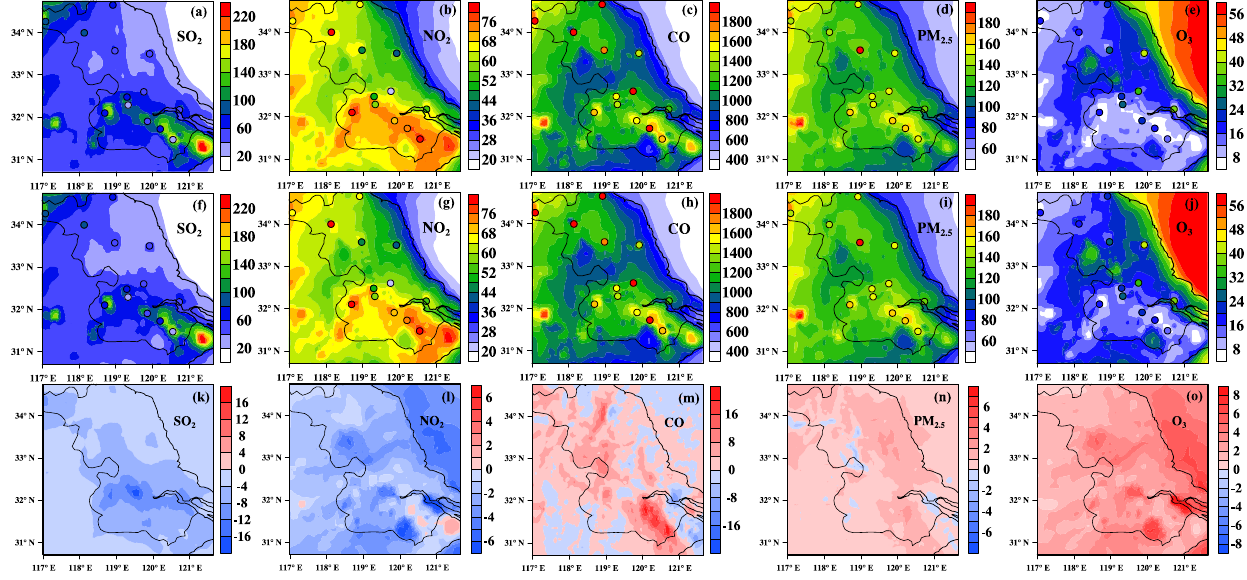
Figure 3. The spatial distributions of near-surface SO 2 , NO 2 , CO, PM 2 . 5 , and O 3 concentrations (µgm − 3 ) from (a–e) MOD1, (f–j) MOD2 and (k–o) the differences between MOD2 and MOD1 averaged over December 2013. The observed concentrations were indicated by colored circles.